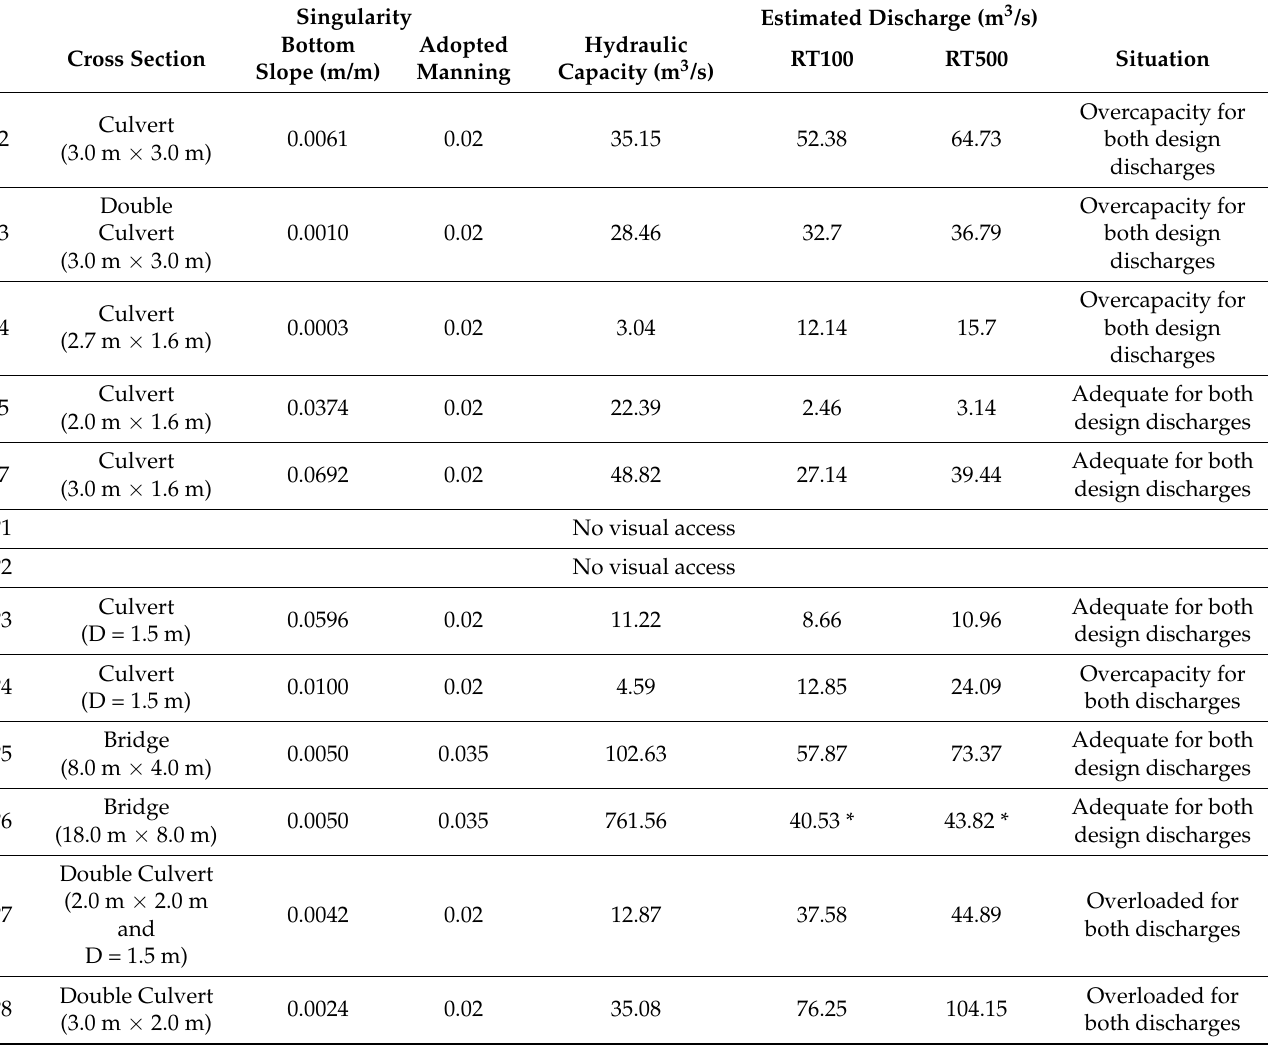
Table 9. Hydraulic evaluation of river crossings in industrial park